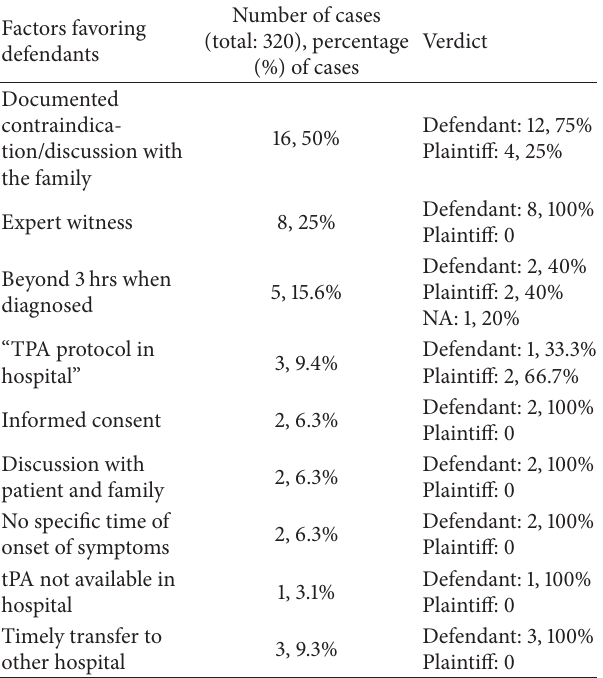
Table 3: Frequency of factors favoring